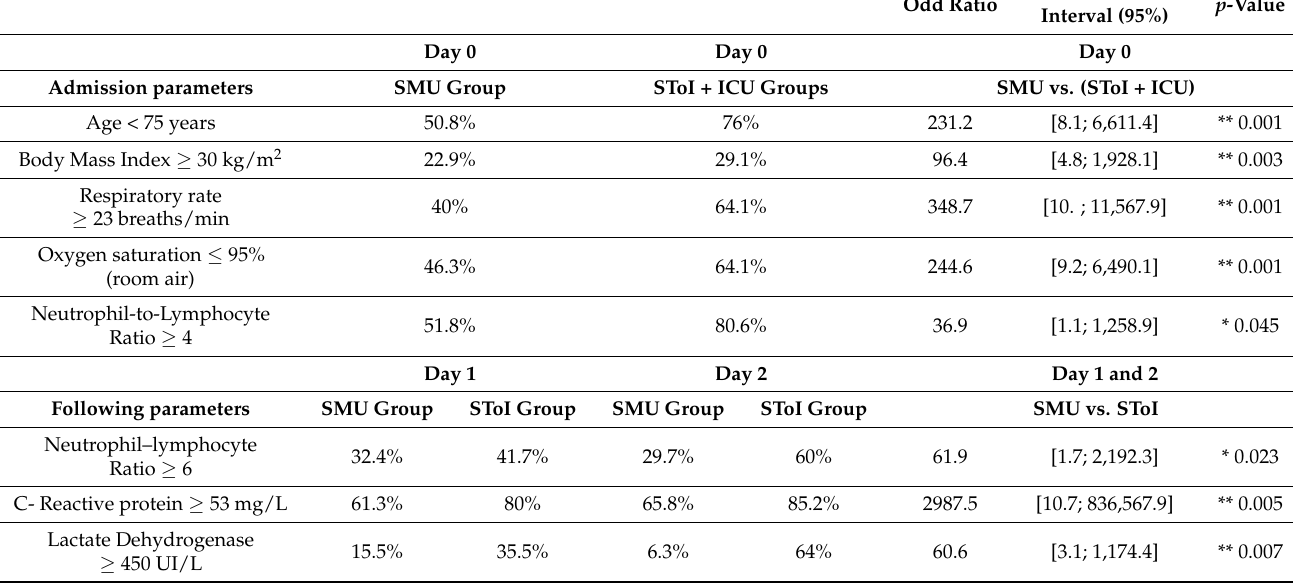
Table 6. Statistical multivariate analysis of PREDICT score parameters during the first two days of hospitalization in standard medical unit (SMU). The two highest severity groups: SToI (need transfer to intensive care unit (ICU)) are compared to the referential group (Standard Medical Unit (SMU)). Parameters with a p -value < 0.05 have significative differences between groups